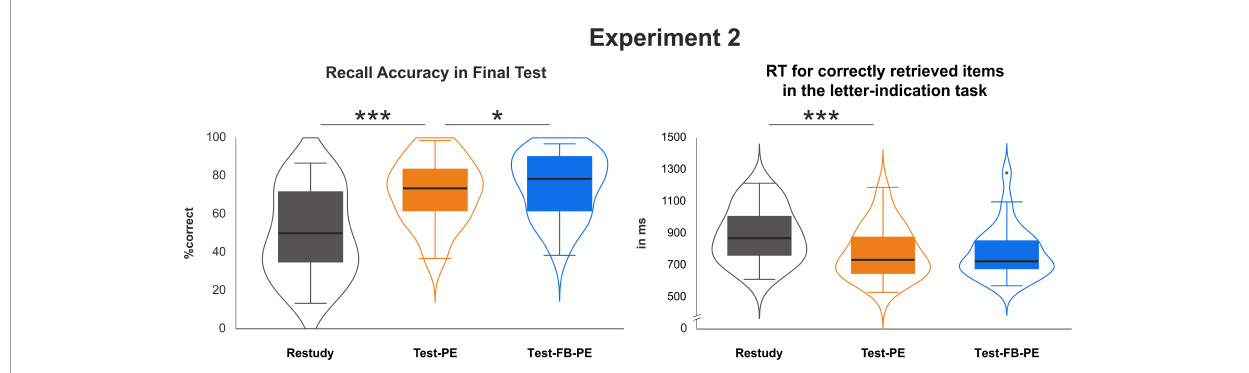
FIGURE5 Recall accuracy and RT results at final test as a function of repetition condition for Experiment 2. The intervention benefit is evident in terms of both increased accuracies and decreased RTs. * p < 0.05 and *** p < 0.001.